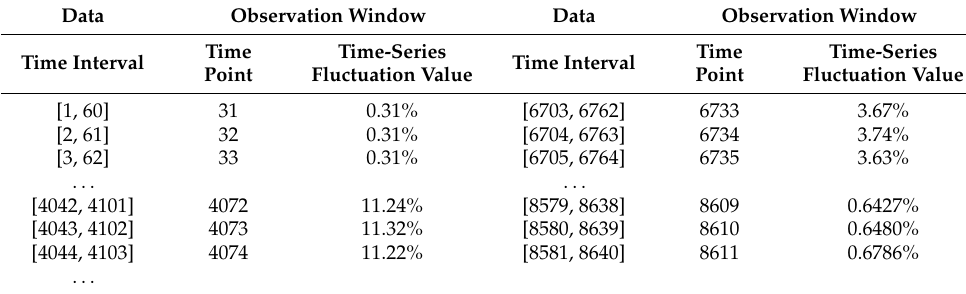
Table 2. Time points of observation window and time-series fluctuation